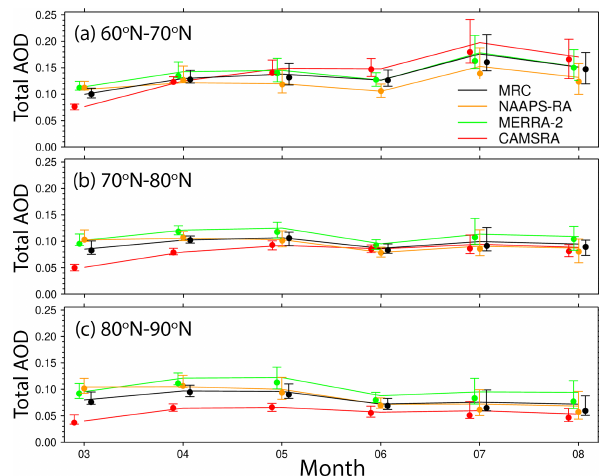
Figure 7. As per Fig. 6 but for total AOD and different latitudinal